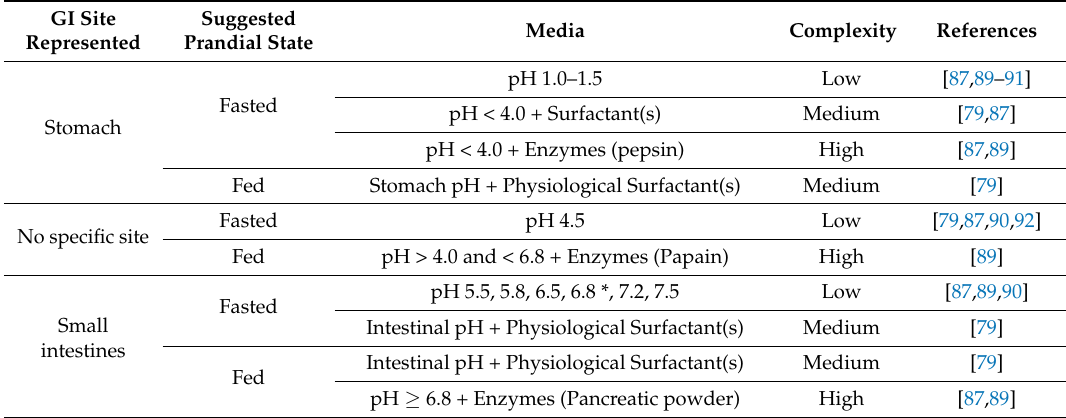
Table 2. Dissolution media in Pharmacopoeias and Guidelines resembling the upper GI